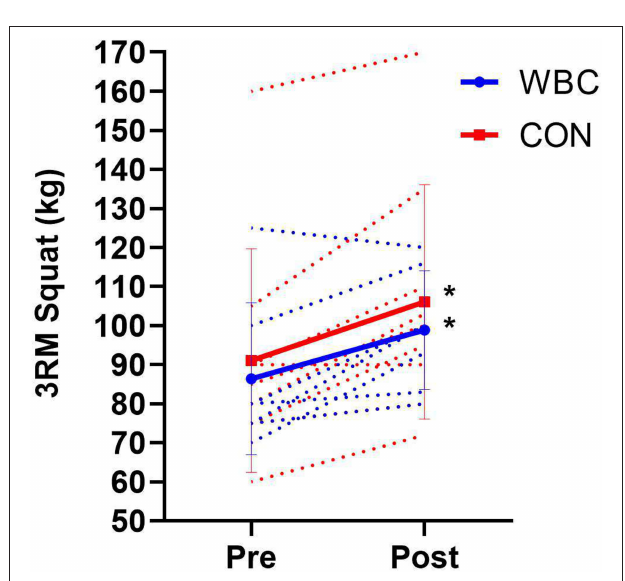
FIGURE 5 | Barbell squat three repetition maximums for WBC ( n = 7) and CON ( n = 9) before and after 6 week training programme. * p ≤ 0.05 for increase in both groups. Solid lines present means ± standard deviations. Dotted lines present individual participant responses. N = 16.